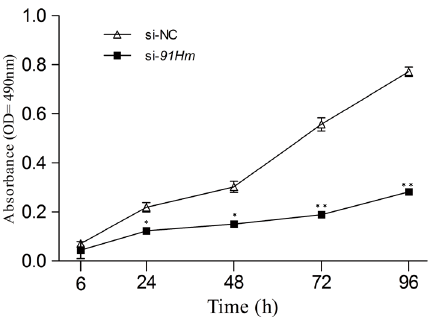
Figure 9. 91H promoted the proliferation of HCT-116 cells via MTT assay (mean ± SEM; P , 0.05).